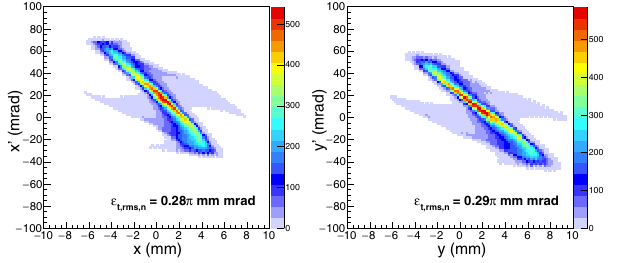
FIG. 9. Phase space distribution of the ion source measured just after the first solenoid magnet of the ion source test stand. The measured beam current was 60 mA.